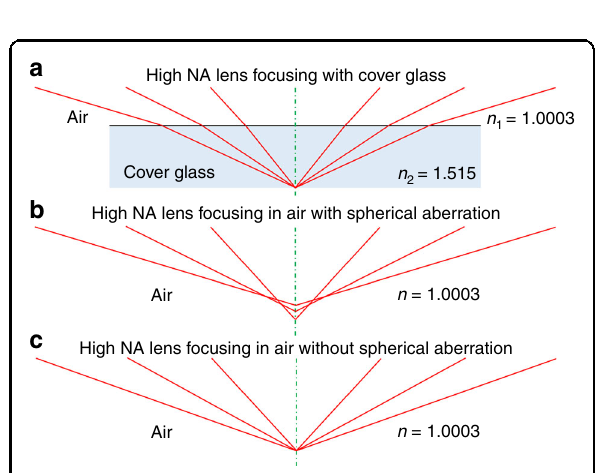
Fig. 9 Illustration of role of spherical aberration effect and its correction in laser beam focusing. Comparison of high NA lens a focused with cover glass, b focused in the air with spherical aberration, and c focused in the air without spherical